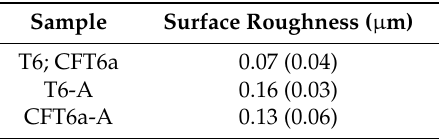
Table 3. Measured surface roughness of different samples before and after anodization.